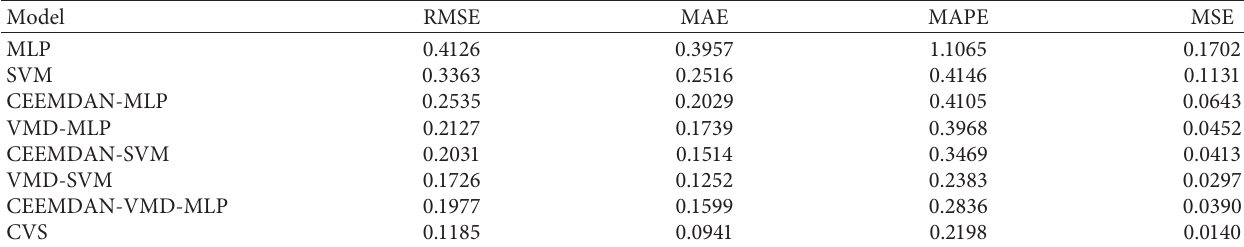
Table 2: Comparison of the evaluation metrics of the CVS model with other models in the training period. Model